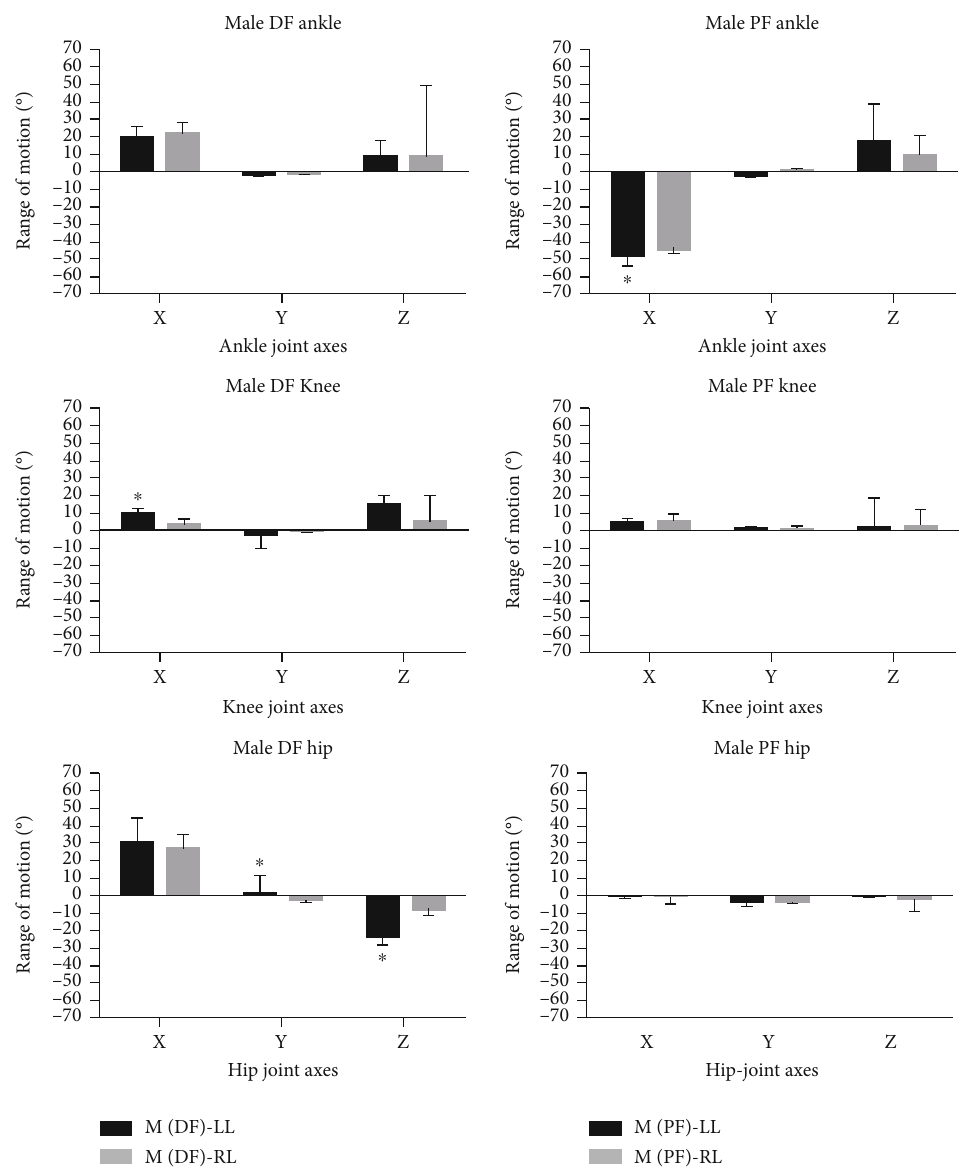
Figure 4: Grouped bar chart representation showing dorsi fl exion (DF) and plantar fl exion (PF) position comparisons between the left limb (LL) and right limb (LL) in male (M) participants at the anterior/posterior ( X ), medial/lateral ( Y ), and vertical ( Z ) directions at the ankle, knee, and hip joints. Error bars included ± standard deviation whilst ∗ indicates statistical signi fi cance ( p < 0 : 05 ) ( n = 12